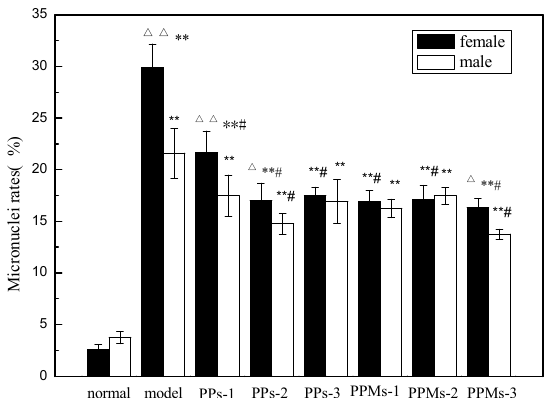
Figure 7. Effect of PP and PPM on the development of micronuclei in bone marrow; the irradiation dose was 6 Gy. * p < 0.05 and ** p < 0.01 compared with the normal group; # p < 0.05 compared with the model group; Δ p < 0.05 compared with the male group in the same indicator and ΔΔ p < 0.05 compared with the male group in the same indicator (mean ± SD, n = 6).